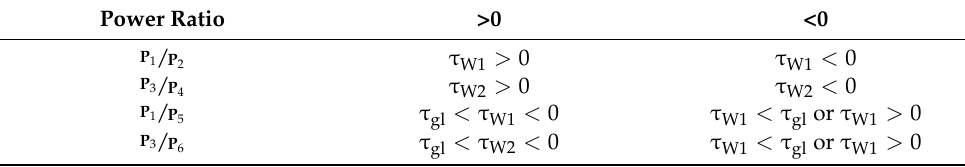
Table 4. Case 2—Ranges of planetary gears speed ratios for each power ratio sign.